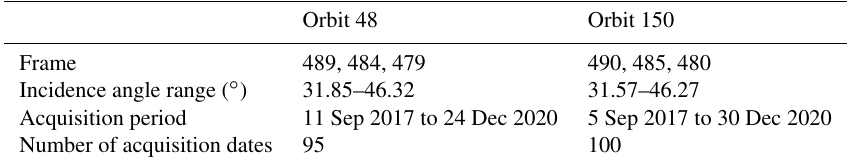
Table A1. Information on the S1 images processed to monitor the surface deformation.